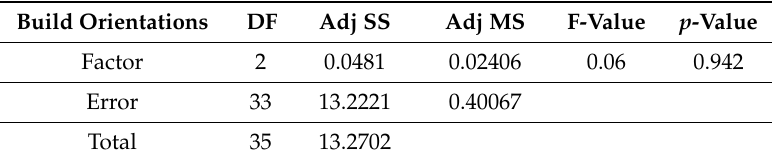
Table 27. ANOVA results for Ra as a function of build orientations.